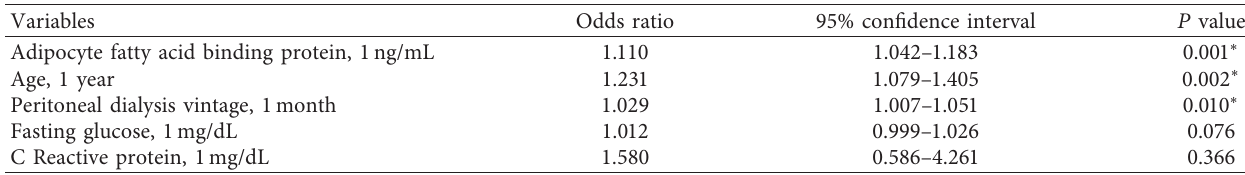
Table 2: Multivariate logistic regression analysis of the factors correlated to aortic stiffness among 76 peritoneal dialysis